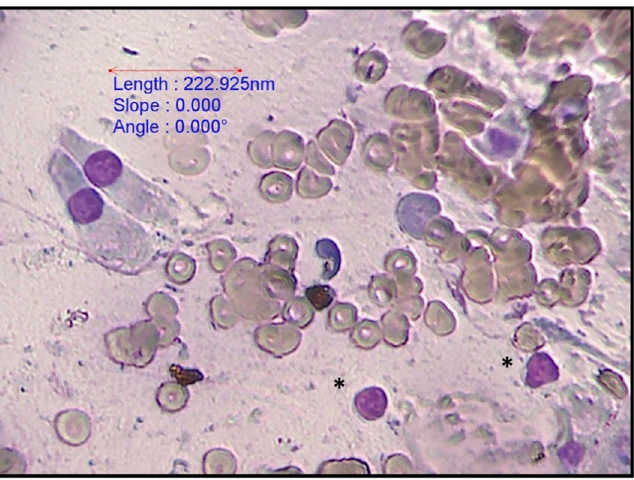
Fig 5. Biliary columnar cells, red blood cells and small lymphocytes ( � ). 40x. Diff-Quik stain, euromex CMEX 5 microscope camera.